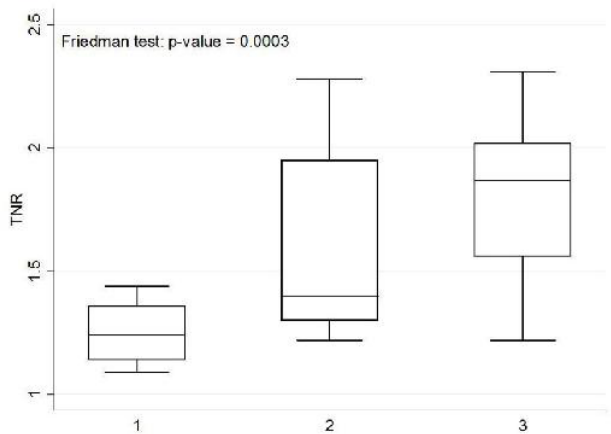
Figure 5. Box plot of TNR based on initial, delayed and further delayed PET / CT imaging. The x-axis represents three separate images: initial image = 1; delayed image = 2; further delayed image = 3. Friedman test: p -value = 0.0003. The TNRs appeared to increase with time and were identified to be significantly di ff erent.